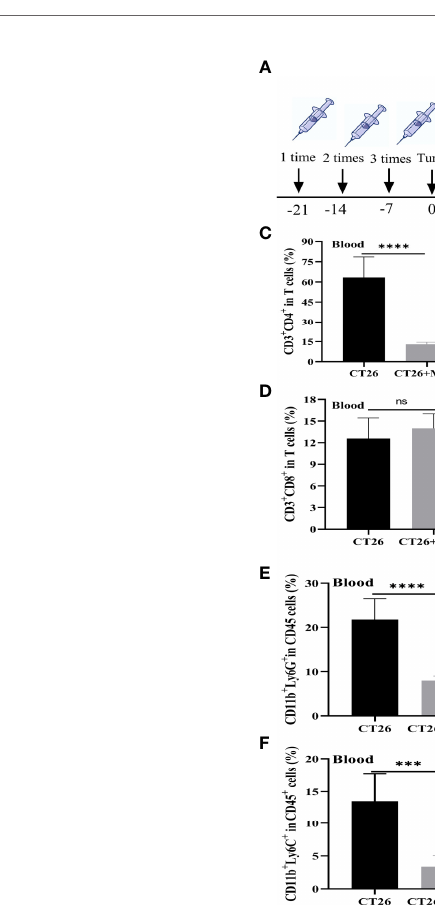
( Figure 2A ). DCs infected with Me49 secreted more exosomes at 12 h than uninfected cells ( Figure 2B ). The diameter range of exosomes from different samples was 100 – 200 nm ( Figure 2C ).